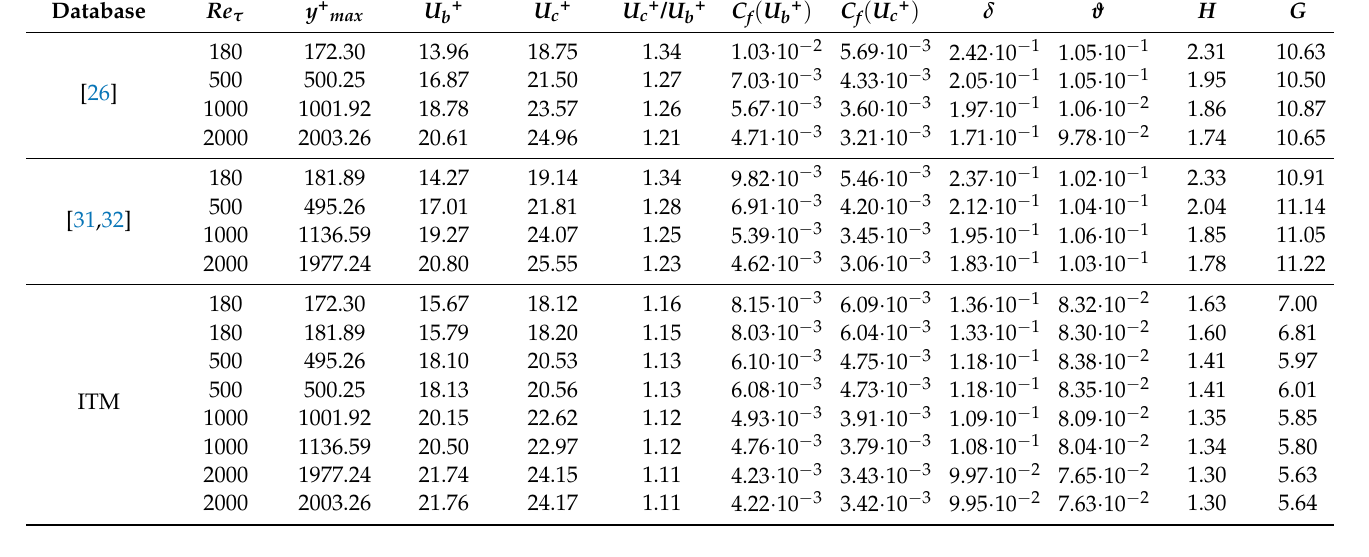
Table 4. Mean flow properties extracted from pipe DNS database [26,31,32] and from channel ITM. The parameters are defined as: U b + is the mean velocity; U c + the centerline velocity; C f the skin friction based on the mean velocity C f on the centerline velocity C f defined as δ ( 2 − δ ) = 2